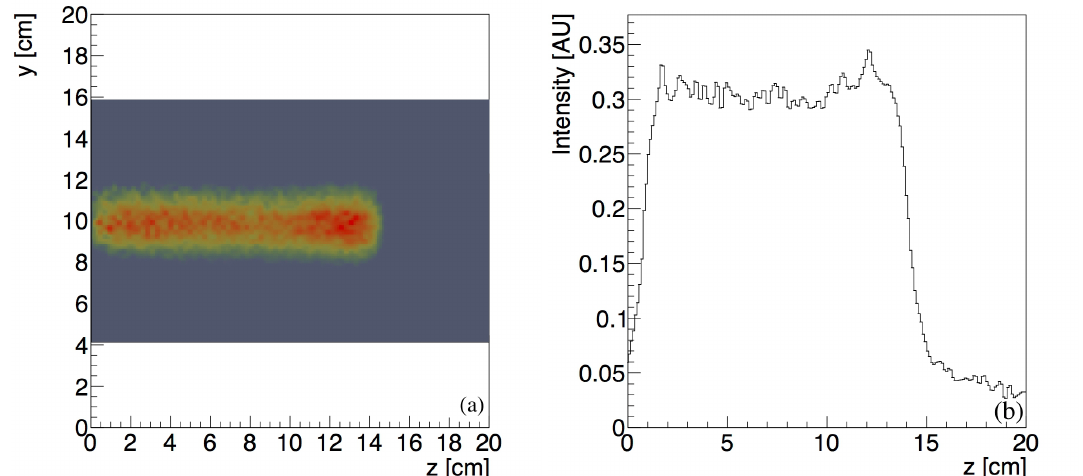
Figure 10. Reconstructed lateral profile at y = 10 cm ( a ); and one-dimensional longitudinal profile ( b ) of the positron emitters produced by a 150 MeV proton pencil beam with approximately 2 mm spot-size and 0.3 MeV energy spread within a PMMA target volume.